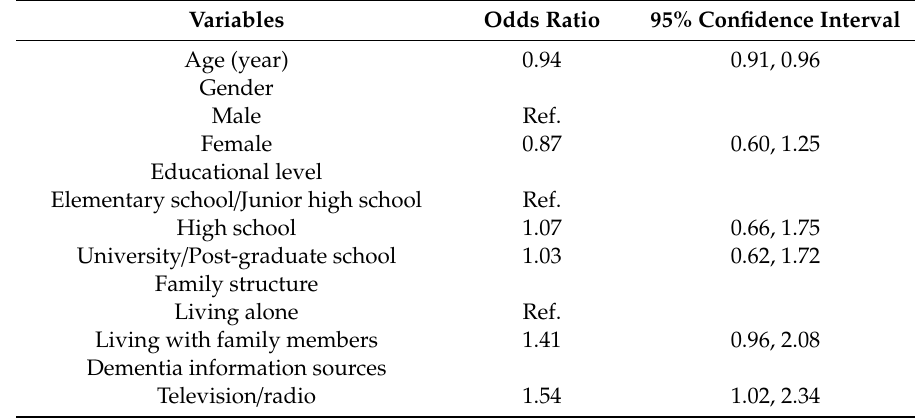
Table 3. Multivariate logistic regression model to identify factors associated with dementia literacy ( n =